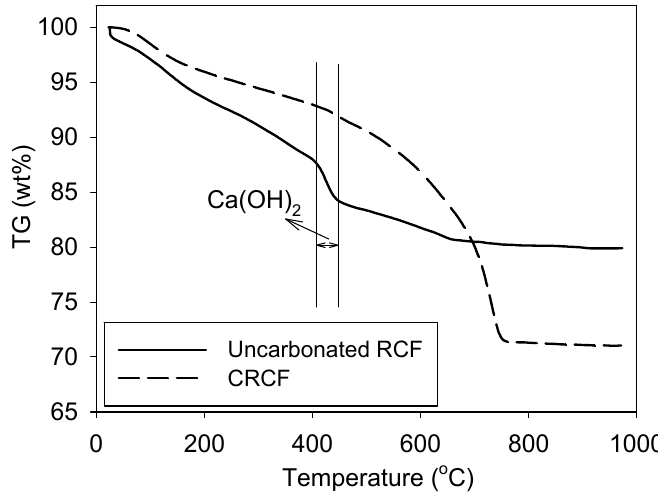
Figure 4. TG curves of the carbonated/uncarbonated recycled fi ne.